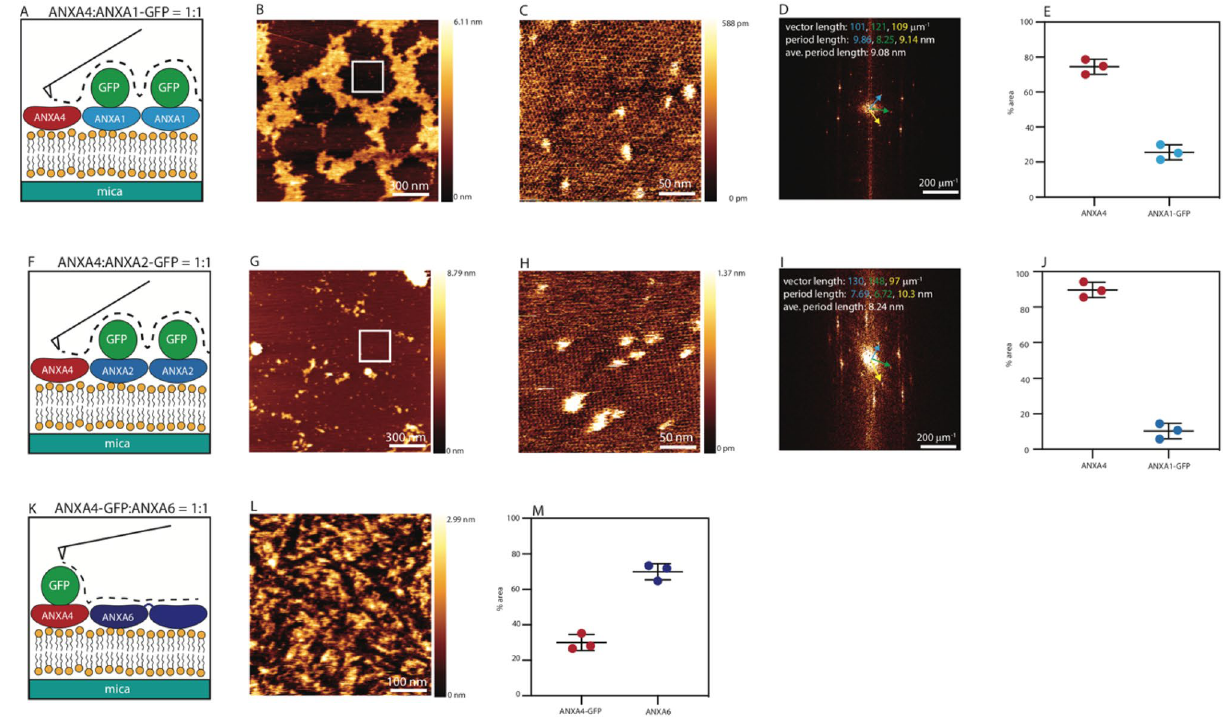
Figure 4. Atomic force microscopy characterization of the mixing of ANXA4 and the crosslinking annexins. Schematic representation of AFM imaging of proteins structures that form when 1:1 annexin mixtures (ANXA4 and ANXA1-GFP ( A ), ANXA4 and ANXA2-GFP ( E ) and ANXA4-GFP and ANXA6 ( I )) are added to DOPC/DOPS (1:1 molar ratio) supported lipid bilayers where the presence of the GFP label on provides a height differential between the two proteins. 1.5 μm scan on a mixture of ANXA1-GFP and ANXA4 indicates that the proteins do not mix ( B ). 250 nm scan (white square, B ) allows ANXA4 trimers to be resolved ( C ). Fourier transform of ( C ) indicates a crystalline structure ( D ). Lattice vectors in Fourier space are indicated by arrows with corresponding vector length and period lengths noted in the same color. 1.5 μm AFM image of the protein structure that forms when a 1:1 mixture of ANXA4 and ANXA2-GFP is added to a supported lipid bilayer (shown schematically, E ) ( F ). 250 nm scan (white square, F ) allows ANXA4 trimers to be resolved ( G ). Fourier transform of ( G ) indicates a crystalline structure ( D ). Lattice vectors in Fourier space are indicated by arrows with corresponding vector length and period lengths noted in the same color. 500 nm AFM image of the protein structure that forms when a 1:1 mixture of ANXA4-GFP and ANXA6 is added to a supported lipid bilayer (shown schematically, I ) ( J ). 250 nm image ( L ). Quantification of area occupied by ANXA4-GFP (red circles) and ANXA6 (purple circles) in a 1:1 mixture in 500 nm scans (N = 20, from 3 independent experiments) indicates that ANXA4-GFP occupies 30% of scan area and ANXA6 occupies 70% of scan area ( M ).